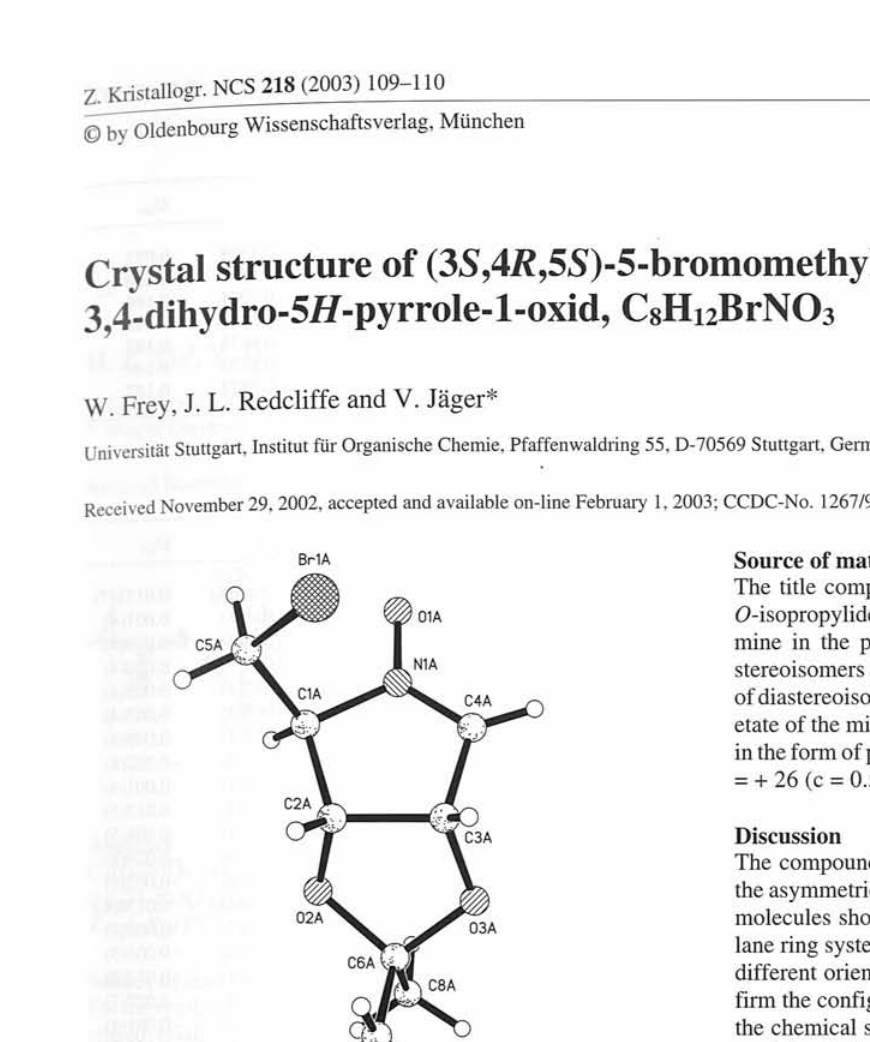
Table 1. Data collection and handling.